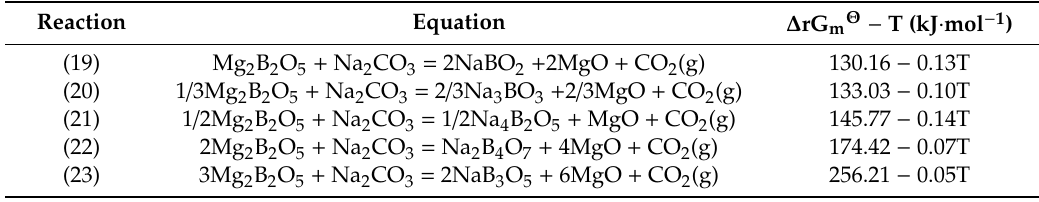
Table 3. ∆ rG m Θ − T equations of Na 2 CO 3 ‐ Mg 2 B 2 O 5 s ystem during roasting (400 °C < T < 1400 °C). Reaction Equation Reaction